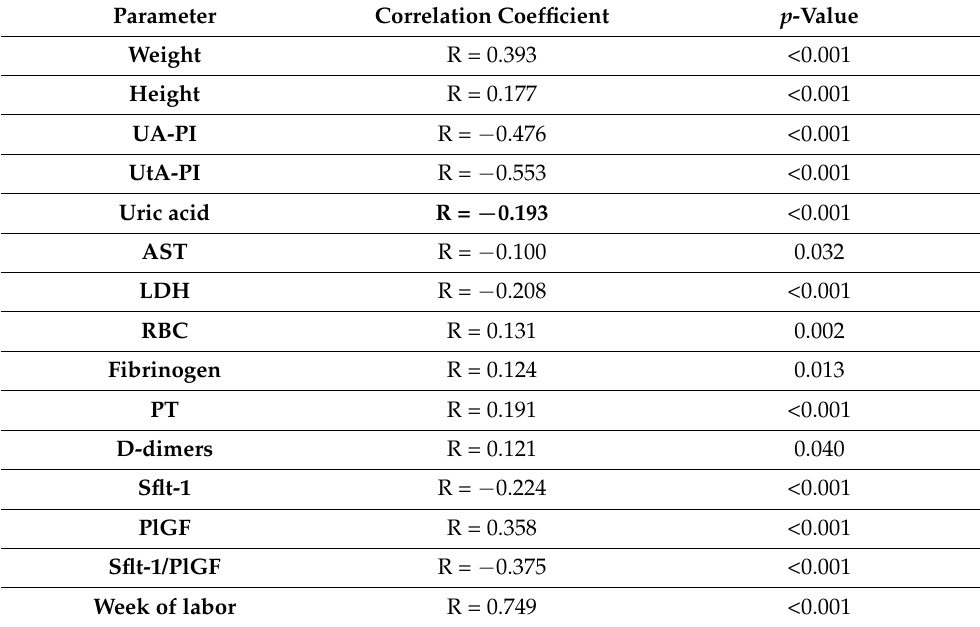
Table 2. Analysis of the correlations between birth weight and the evaluated parameters across the entire study group.